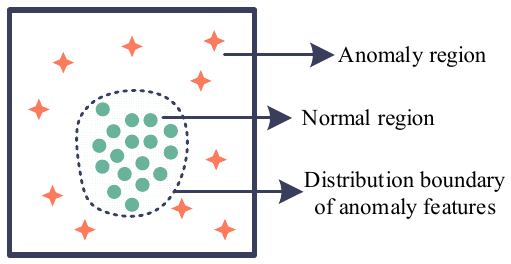
Figure 6. The description of anomaly feature distribution.